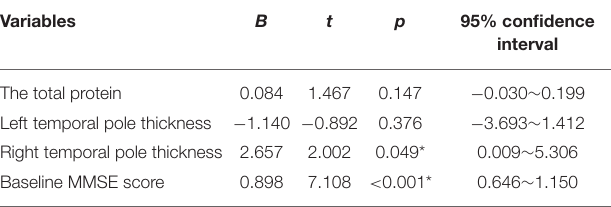
TABLE 3 | Influencing factors of follow-up Mini-Mental State Examination (MMSE) scores (linear regression analysis). Variables B t p 95% confidence